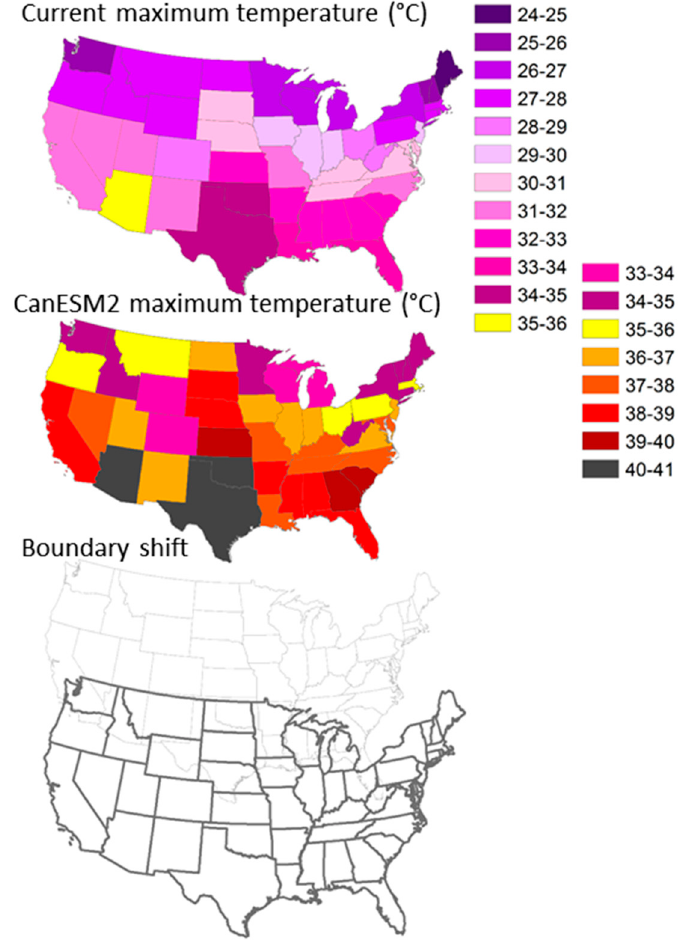
Figure 4. Current hottest month by state and hottest month by state under CanESM2 RCP 8.5.